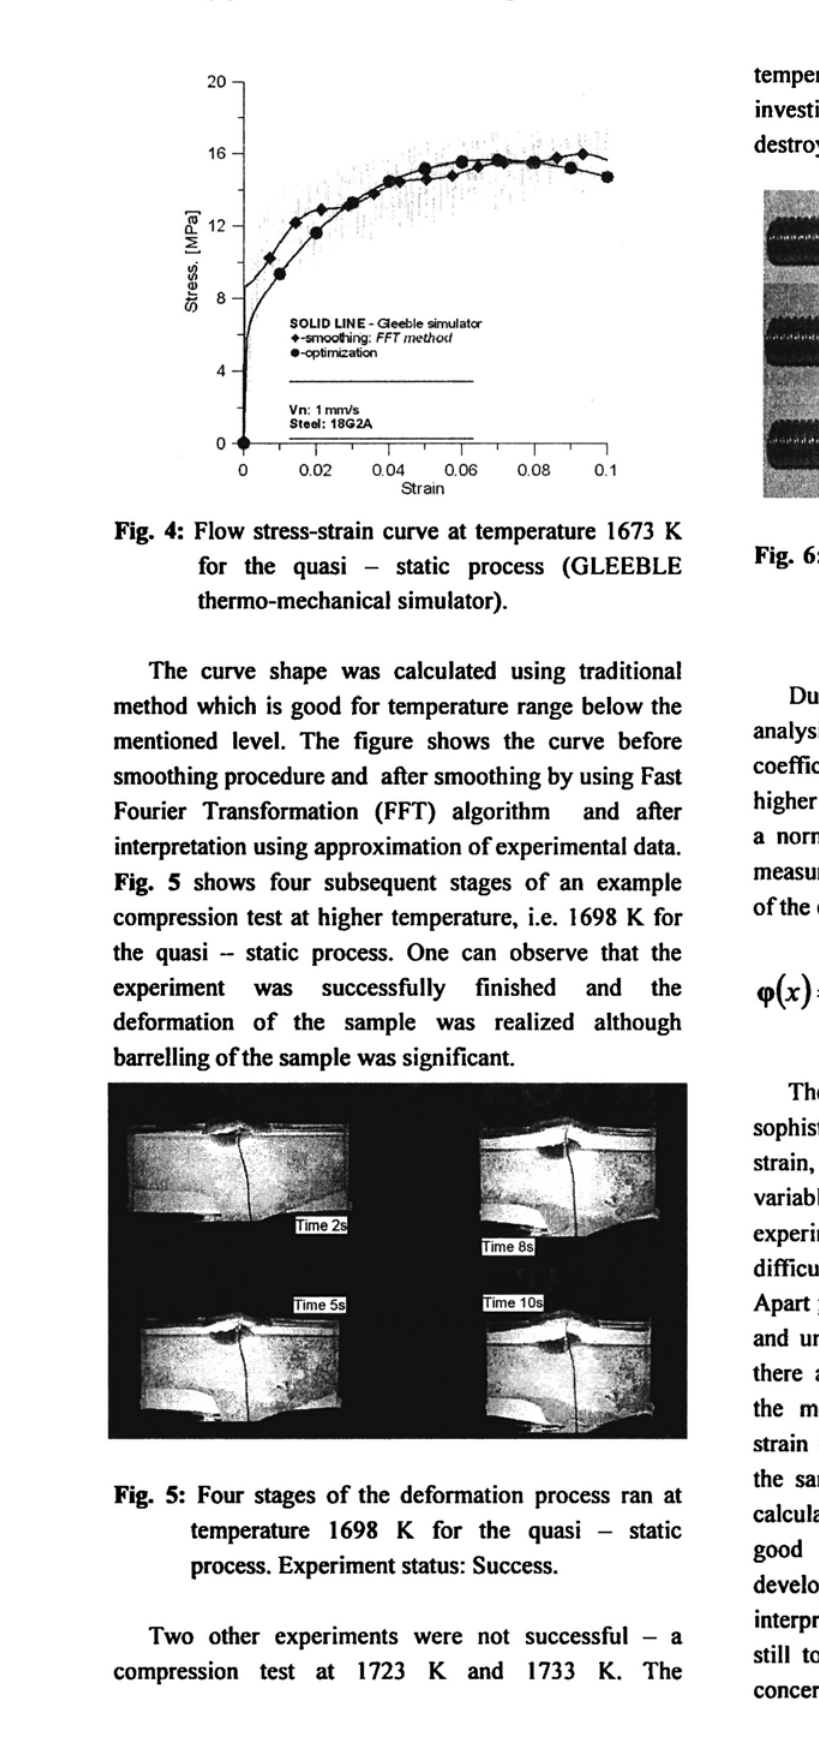
Fig. 5: Four stages of the deformation process ran at temperature 1698 K for the quasi - static process. Experiment status: Success. Two other experiments were not successful - a compression test at 1723